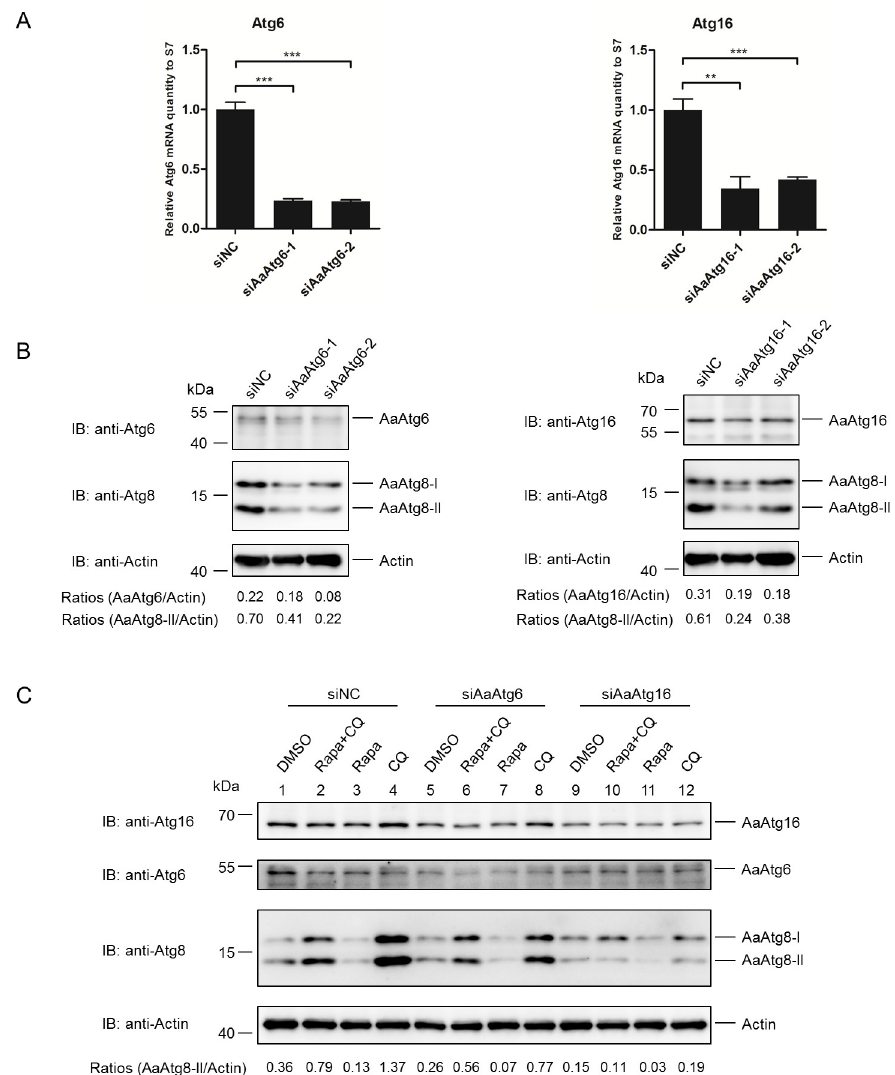
Fig 6. AaAtg6 and AaAtg16 were involved in Rapa induced autophagy. (A) C6/36 cells transfected with equal amounts of RNA of siNC, siAaAtg6-1, siAaAtg6-2, siAaAtg16-1 or siAaAtg16-2 for 48 hours, respectively. RNAi efficiency of AaAtg6 and AaAtg16 were quantified by qPCR analysis. (B) Lysates prepared from C6/36 cells primary treated as described in (A), and subjected to Western Blotting using antibody against AaAtg6, AaAtg16 and AaAtg8, respectively. (C) C6/36 cells transfected with siNC, siAtg6-2 or siAtg16-1 for 24 hours then treated with Rapa or CQ for 24 hours and 12 hours, respectively. For Rapa plus CQ treatment, C6/36 cells were treated with Rapa for 12 hours then treated with CQ for another 12 hours. The protein levels of AaAtg16, AaAtg6, AaAtg8 and actin were analysed by Western Blotting, respectively. The relative level of AaAtg8-II to that of actin was quantified by ImageJ according to materials and methods. Data were presented as means ± SD for three biological replicates. The statistical significances were calculated by t test, �� P < 0.01, ��� P <